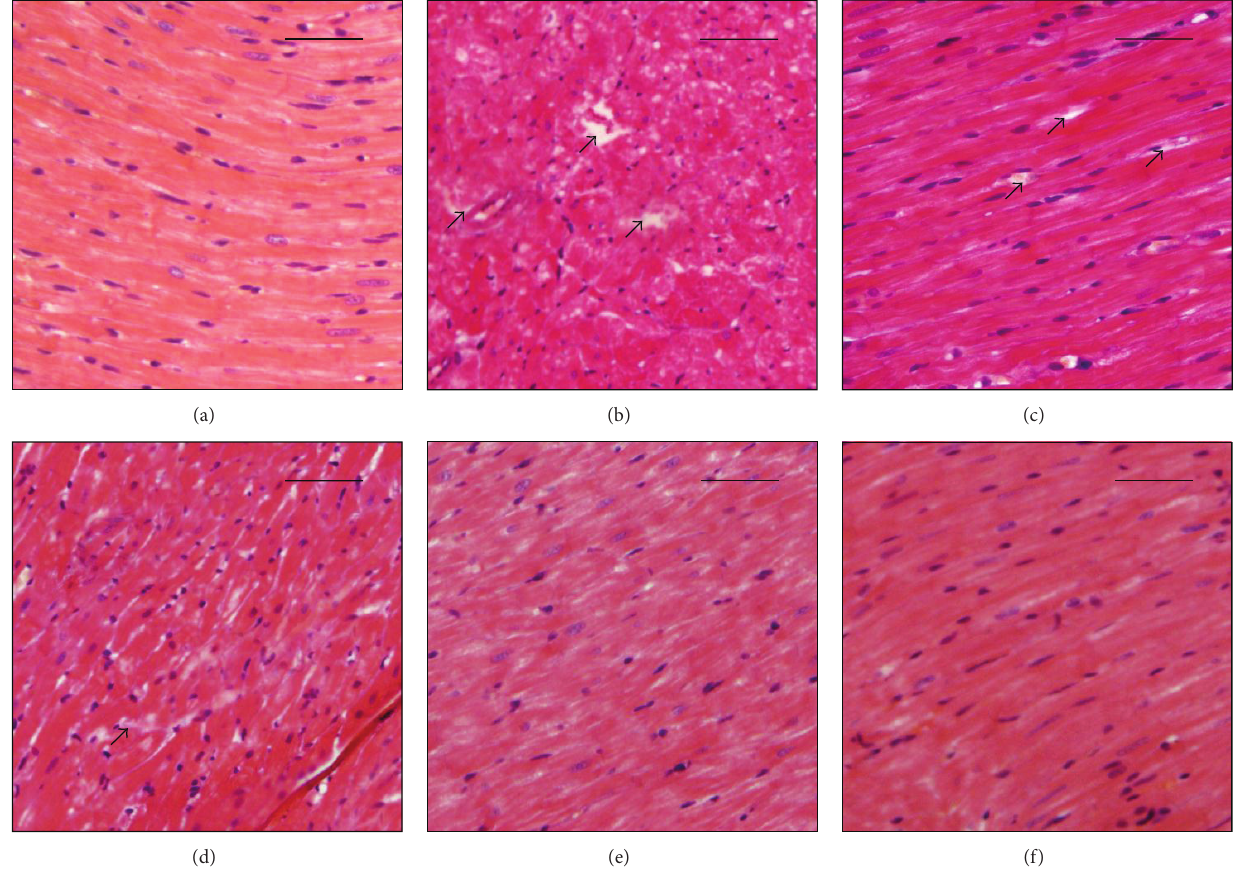
Figure 1: Histopathological improvement of LIRA-treated diabetic myocardium. The normal myocardium, diabetic myocardium and LIRA or ISN treated DCM myocardium were stained with HE staining (200x magnification). Representative samples of normal rats (a), diabetic cardiomyopathy rats (b), INS treated DCM rats (c), and LIRA treated DCM rats ((d) to (f)) were shown in the figure. Arrows indicate regions with ischemic myocyte degeneration in the subendocardial, subepicardial region and papillary muscles of the myocardium. Bar = 50 𝜇